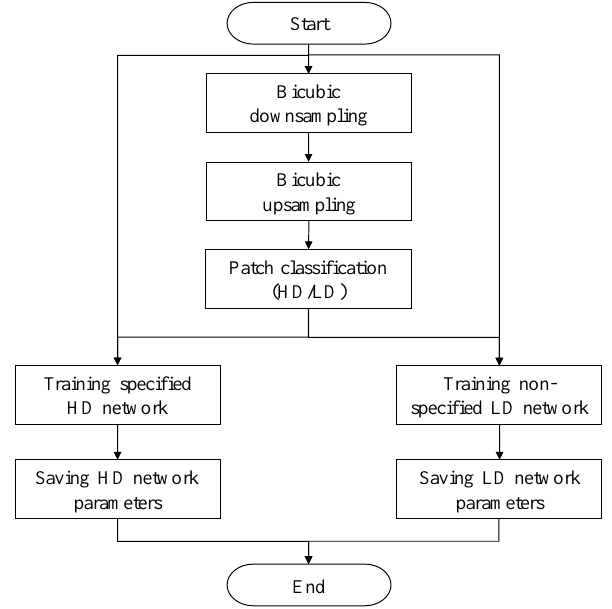
Figure 14. Architecture for simultaneous learning of patch orientation-specified and non-specified neural networks [10].